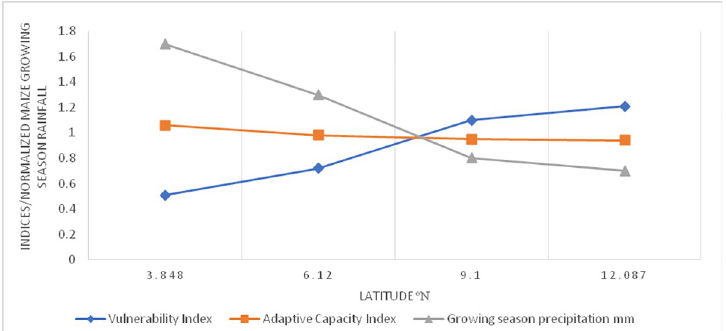
Fig 11. Latitudinal evolution of sub-national maize vulnerability indices, adaptive capacity indices and normalized maize growing season precipitation in Cameroon. Source: Authors’ conceptualization.